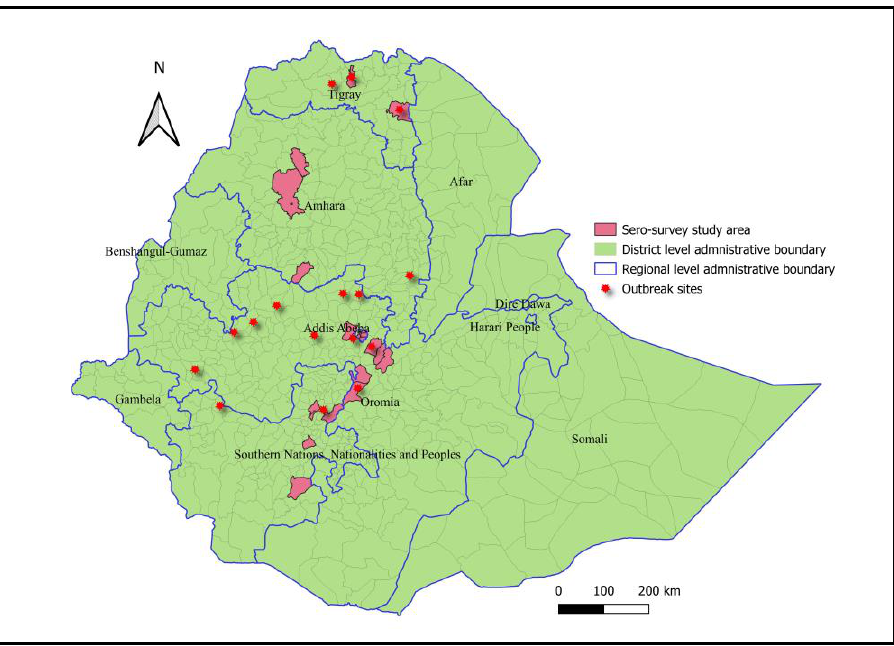
Figure 1. Map of study areas for the FMD outbreak investigation and sero-survey in